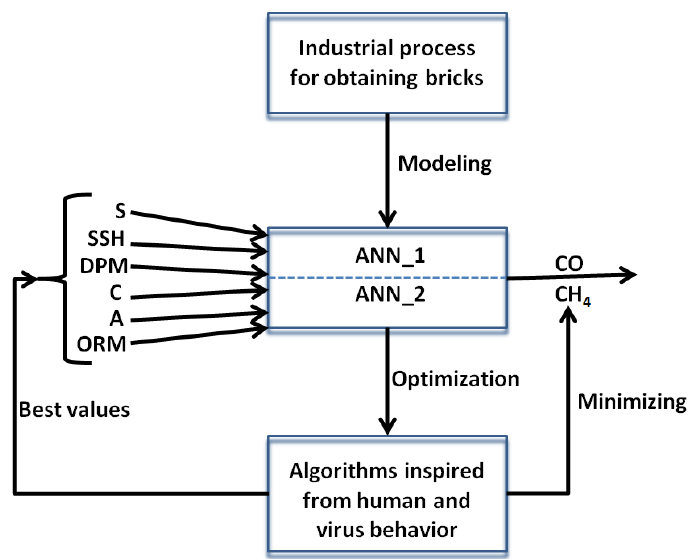
Figure 1. Methodology for modeling and optimizing experimental data (S = sawdust; SSH = sunflower seed husks; DPM = dry product mass; C = the amount of clay; A = the amount of ash; ORM = the amount of organic raw materials).